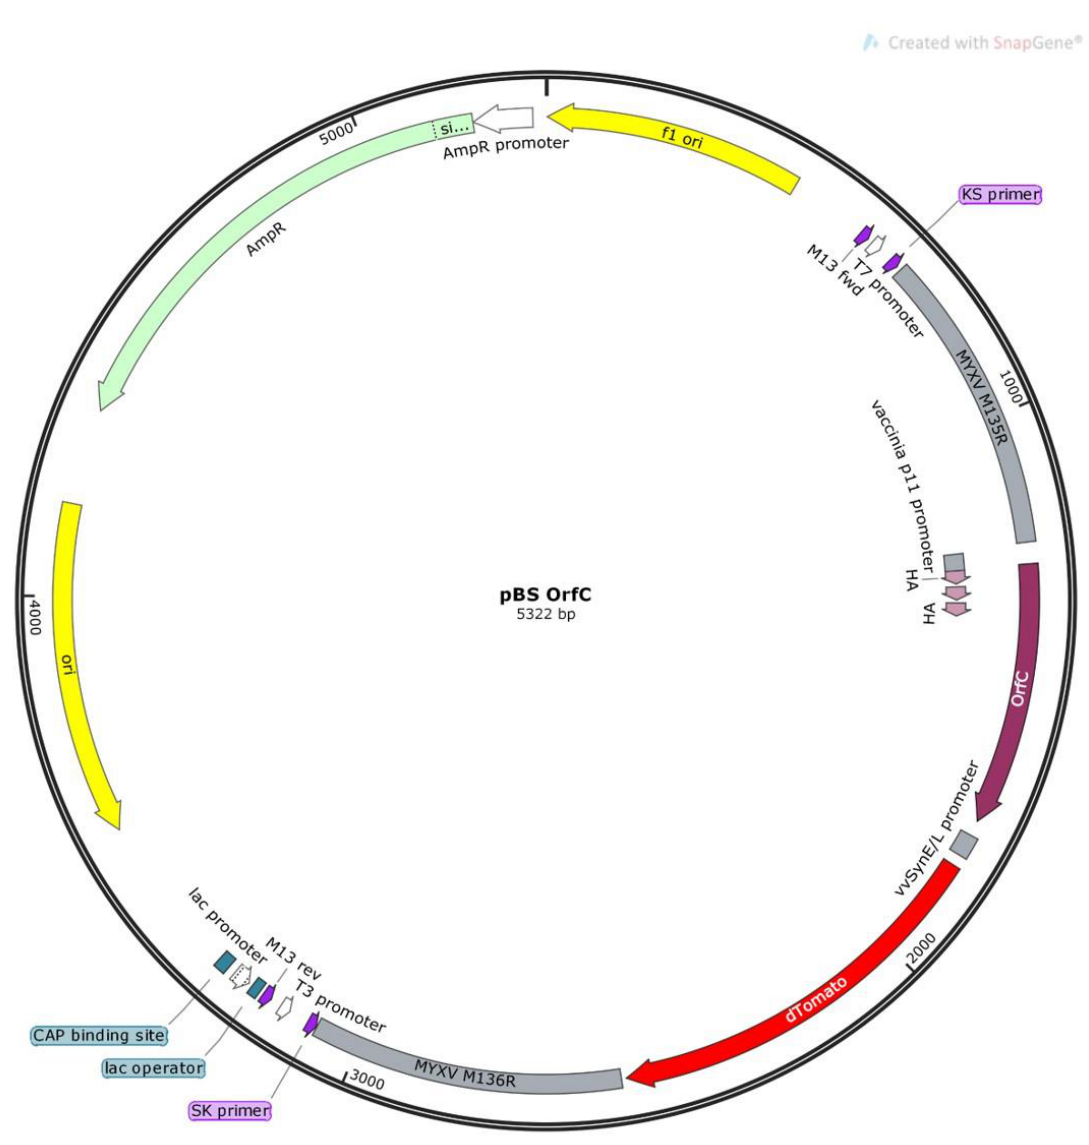
Figure 1. Plasmid design. Diagram (SnapGene, GSL Biotech, San Diego, CA, USA) of the modified pBluescipt plasmid containing the WDSV orfC gene and the tdTomato reporter gene flanked by MYXV M135R and MYXV M136R.